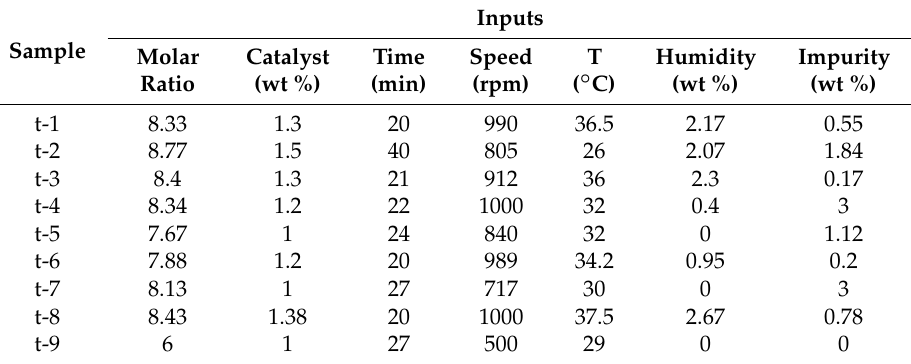
Figure 3. Results of the training period (50 times repeated 10 fold cross-validation) using SVM with a RBF kernel to predict the feature ‘ µ ’. Values of the most accurate configuration: Cost = 1.4 and sigma = 0.2. Table 6. Test matrix for transesterification process.